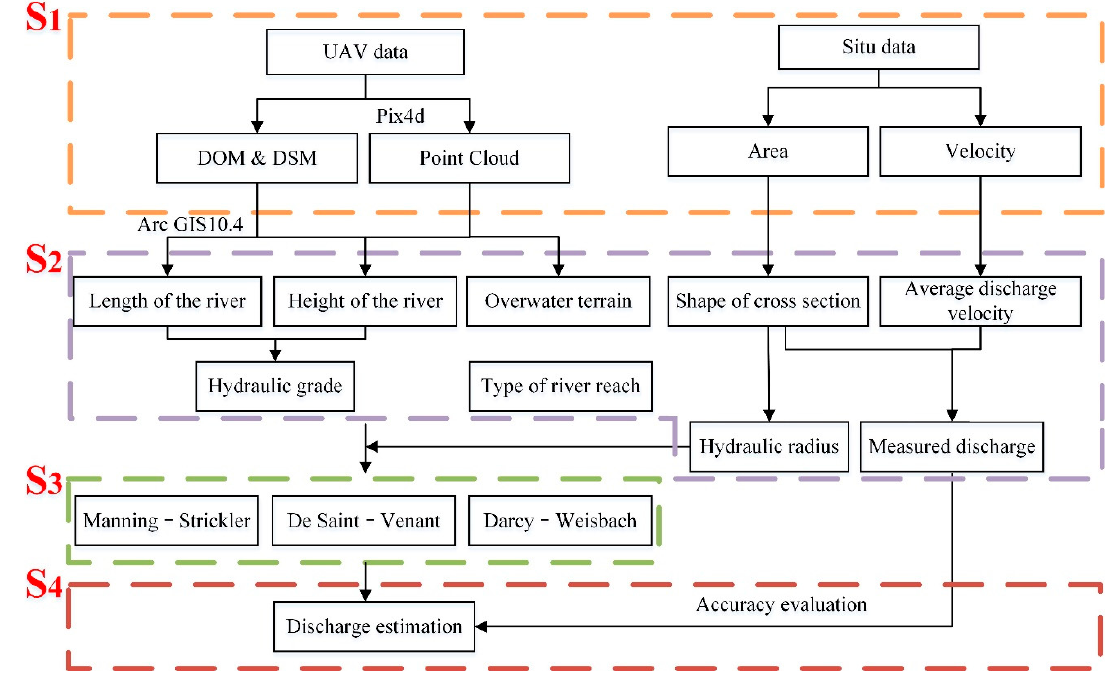
Figure 1. Process of river discharge estimation in this study. Note: S1–4 represents steps 1–4. UAV = unmanned aerial vehicle; DOM = digital orthophoto map; DSM = digital surface model.